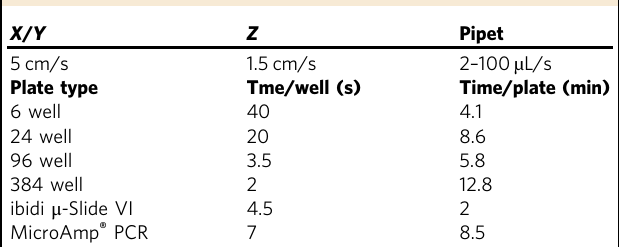
Table 1 PHIL pipet movement and liquid fl ow enables rapid automatic media exchange in common multi-well plate